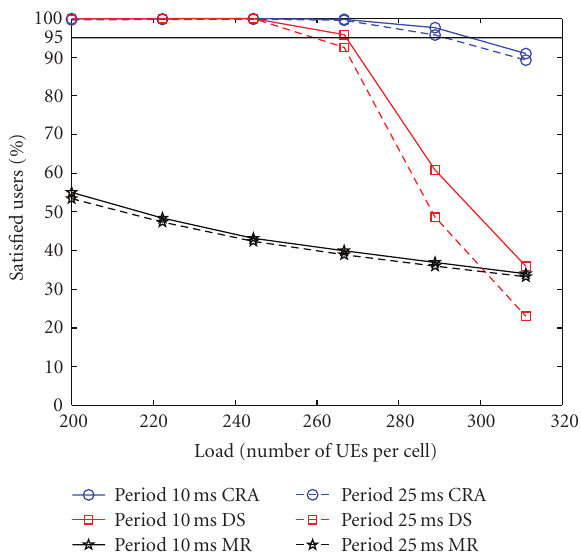
Figure 6: User satisfaction ratio in the VoIP-only scenario with variable channel state reporting periods for CRA, DS and MR schedulers.